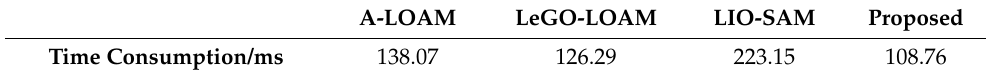
Table 6. Comparison of average total time consumption of each algorithm in single